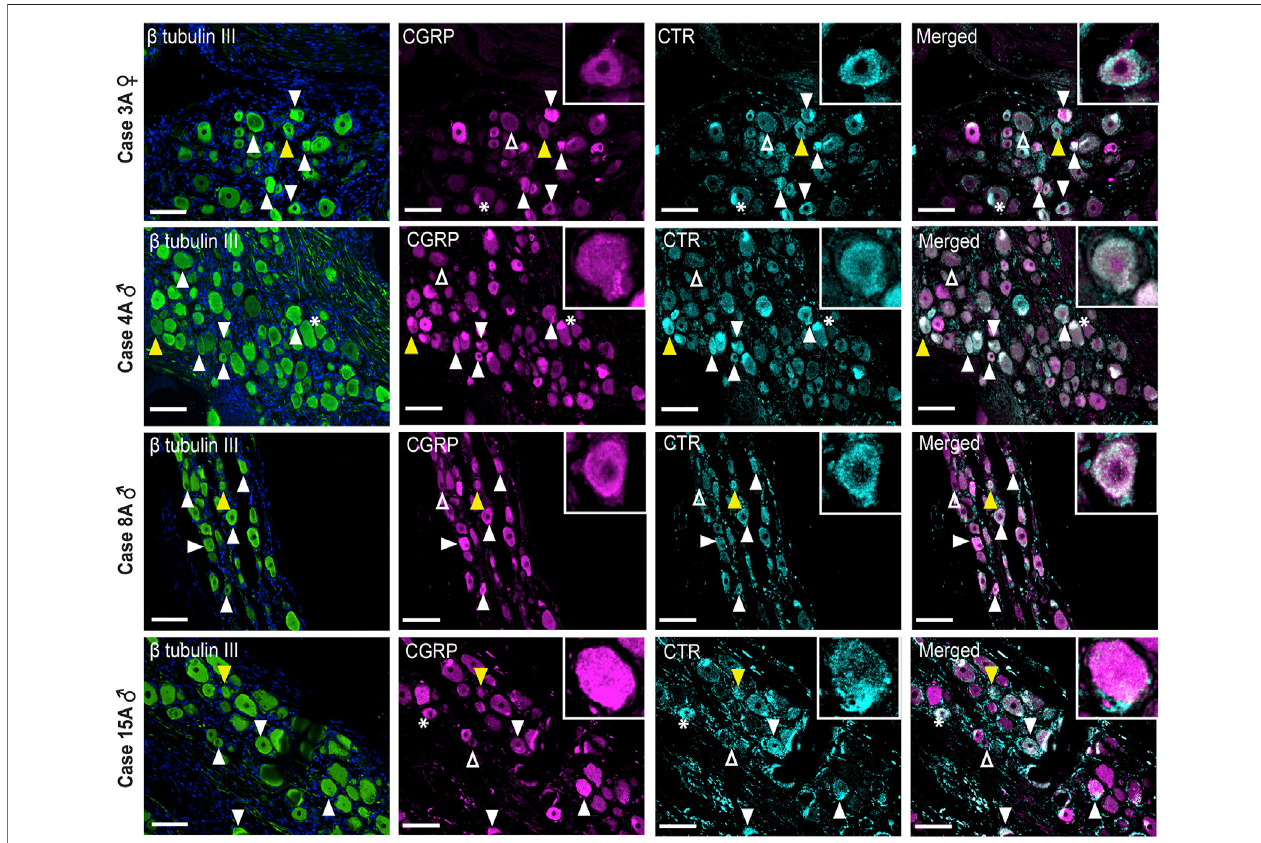
FIGURE 8 | Immunohistochemical localization of CGRP (pAb36001, 10 µg/ml) and CTR (mAb31-01, 4 µg/ml) together with β tubulin III (1.2 µg/ml) in human TG. CGRP and CTR in four human cases (3A, 4A, 8A and 15A). β tubulin III is shown for reference. Filled white arrowheads indicate examples of positive staining; empty arrowheads indicate examples of an absence of staining; yellow arrowheads indicate expression in adjacent neurons. *Indicates examples of auto fl uorescence due to lipofuscin. Image brightness and contrast were adjusted for presentation purposes and merged in FIJI. Scale bar = 100 μ m. Images are from each of the four human